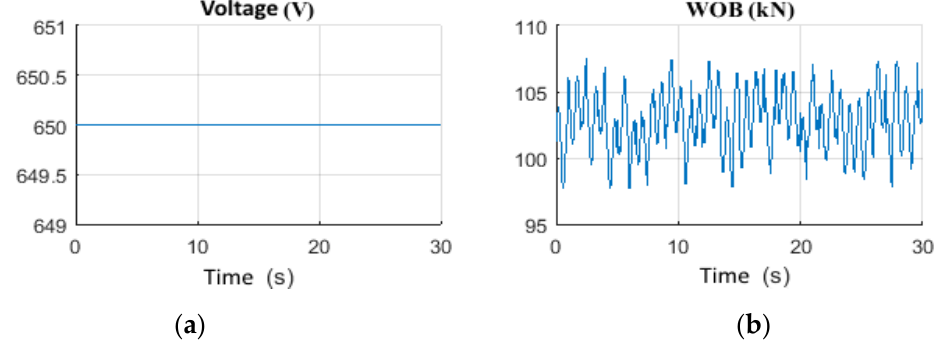
Figure 16. Test inputs of the observer for Scenario-4: ( a ) Top drive motor voltage, ( b ) Applied Weight on bit.